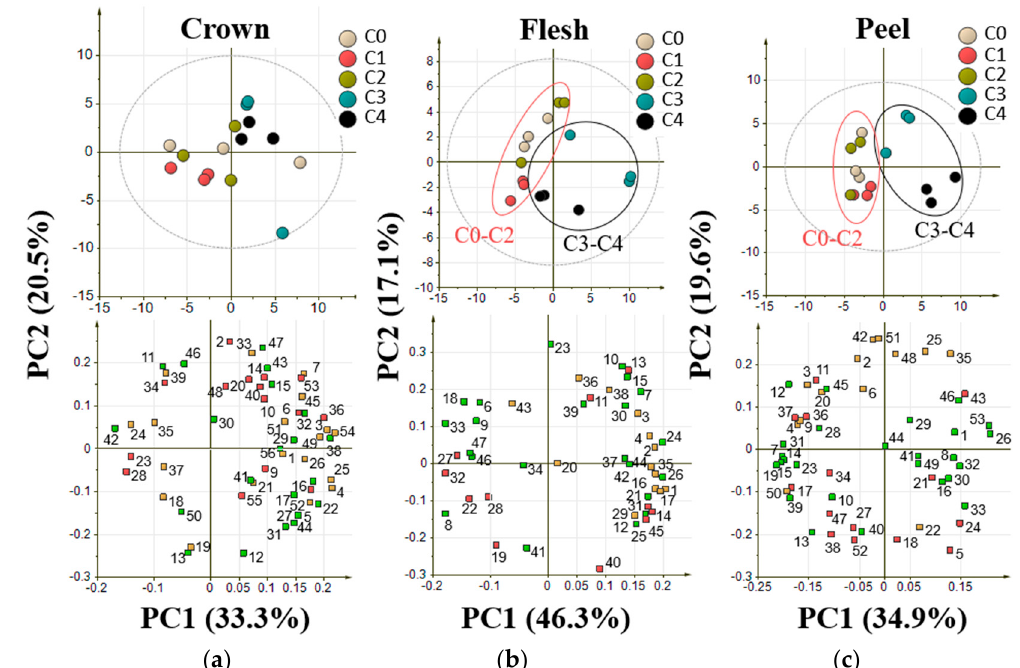
Figure 4. PCA result from flesh, crown and peel parts of pineapple from different ripening stages. Variables used for PCA were 56, 47, and 54 annotated metabolites by GC-MS from crown, flesh, and peel parts respectively. Data was auto scaled prior to PCA. ( a ) Score and loading plot from the crown part; ( b ) score and loading plot from the flesh part; ( c ) score and loading plot from the peel part. Legends represent the samples and colored as follows: brown: C0 stage, red: C1 stage, green: C2 stage, blue: C3 stage, black: C4 stage. Upper part show score plot; Bottom part show loading plot. Loading plot was colored based on metabolite classes: green: sugars; red: organic acids; yellow: amino acids and amines.